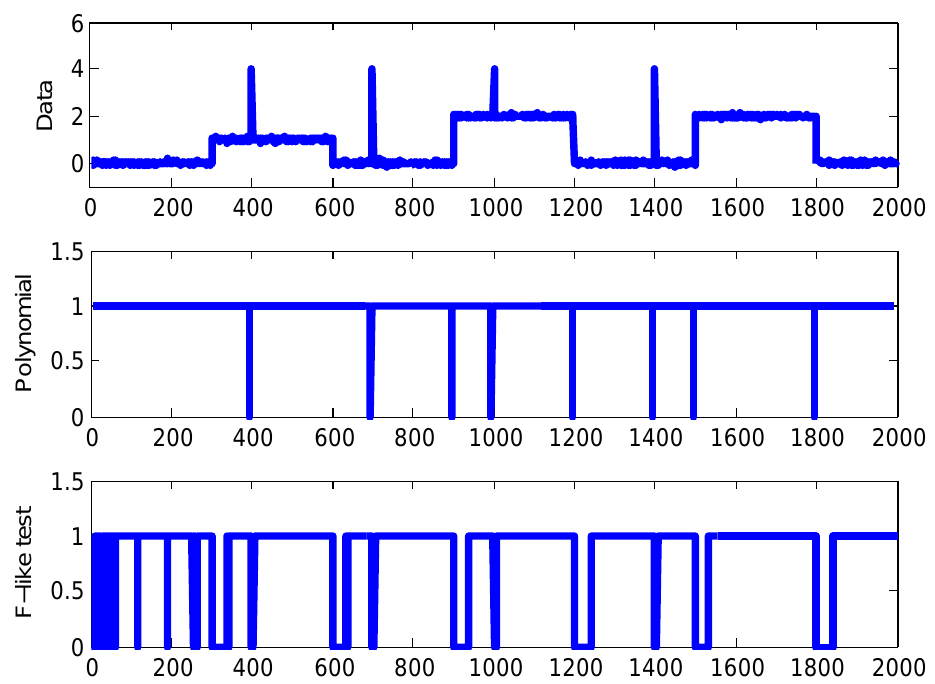
Figure 2. Case 2. Simulated data results with 5% of noise with gross error, in which a window of 10 was used for the polynomial